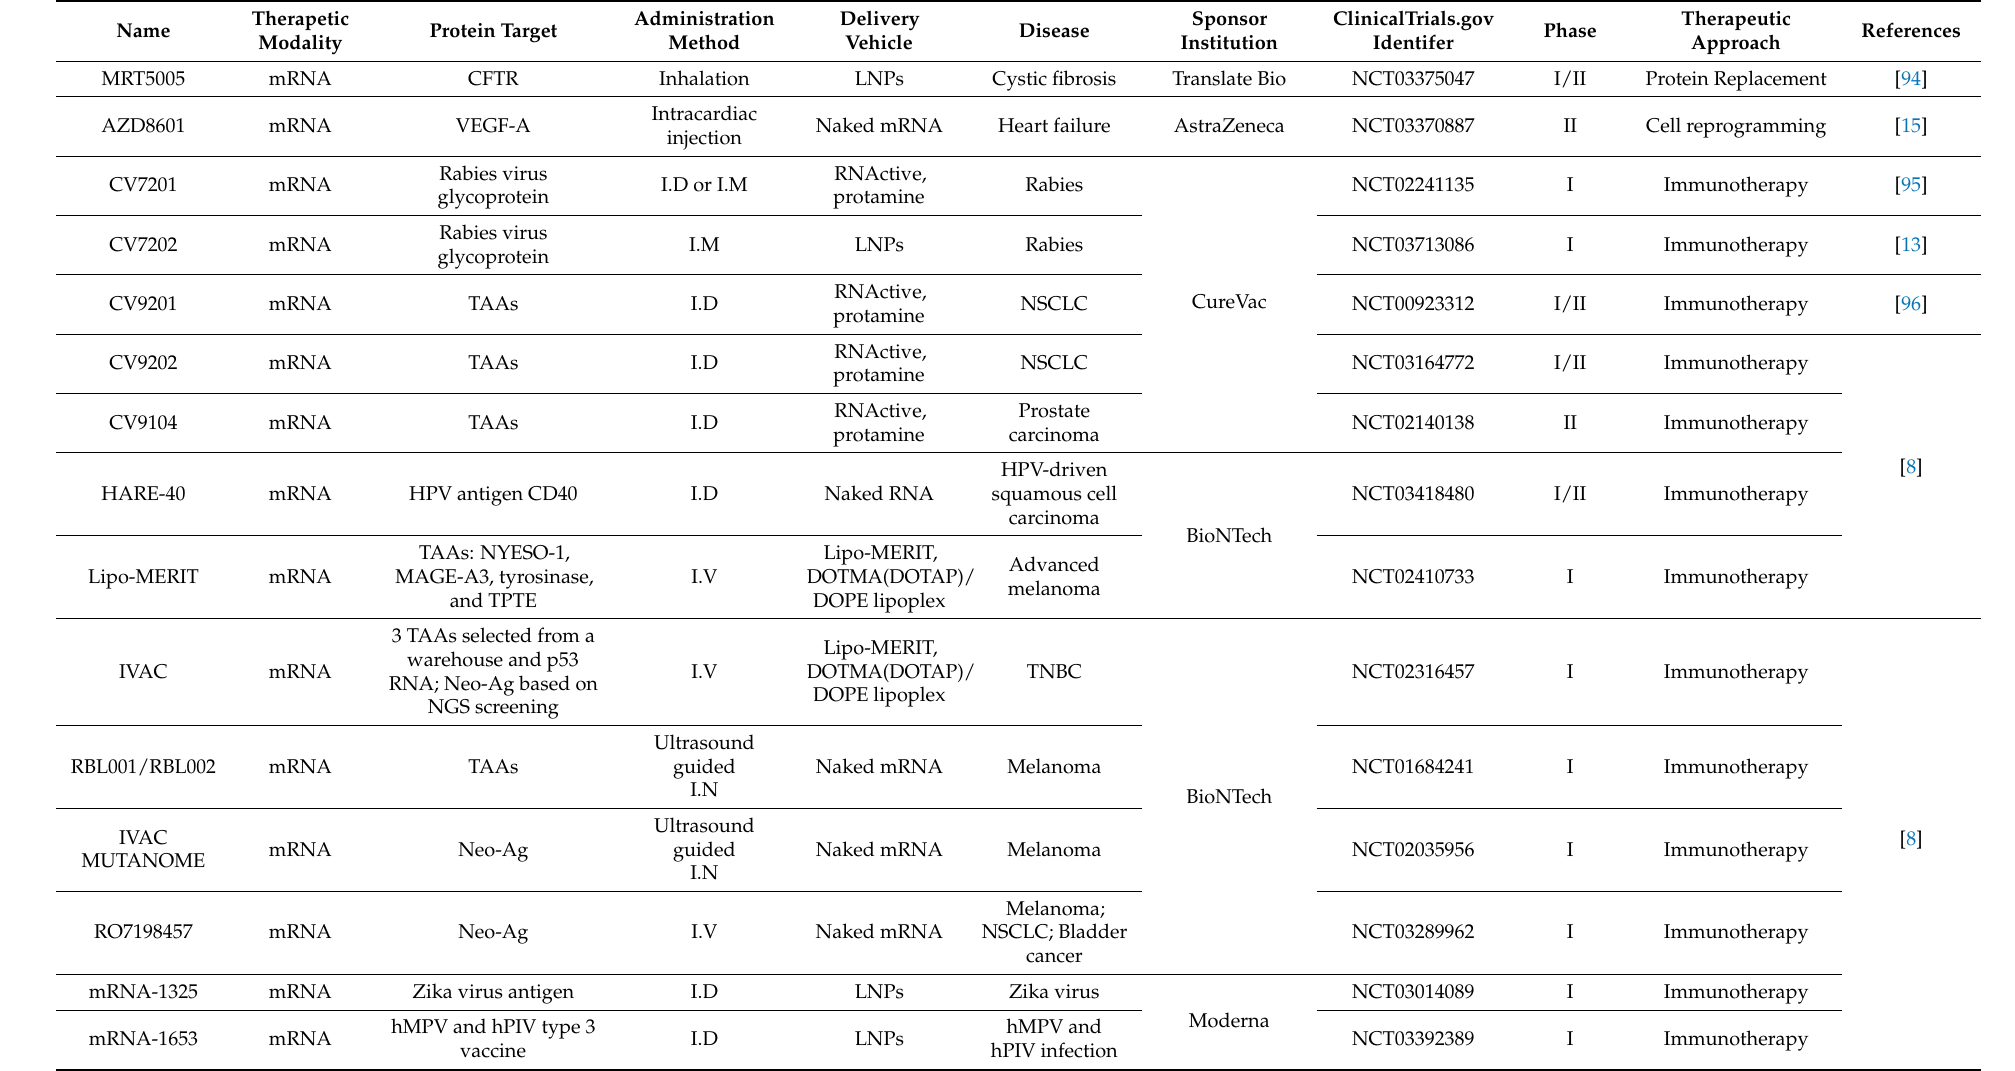
Table 4. Clinical trials for RNA-Based Protein Therapy (Protein replacement, cell reprogramming, immunotherapy) and gene